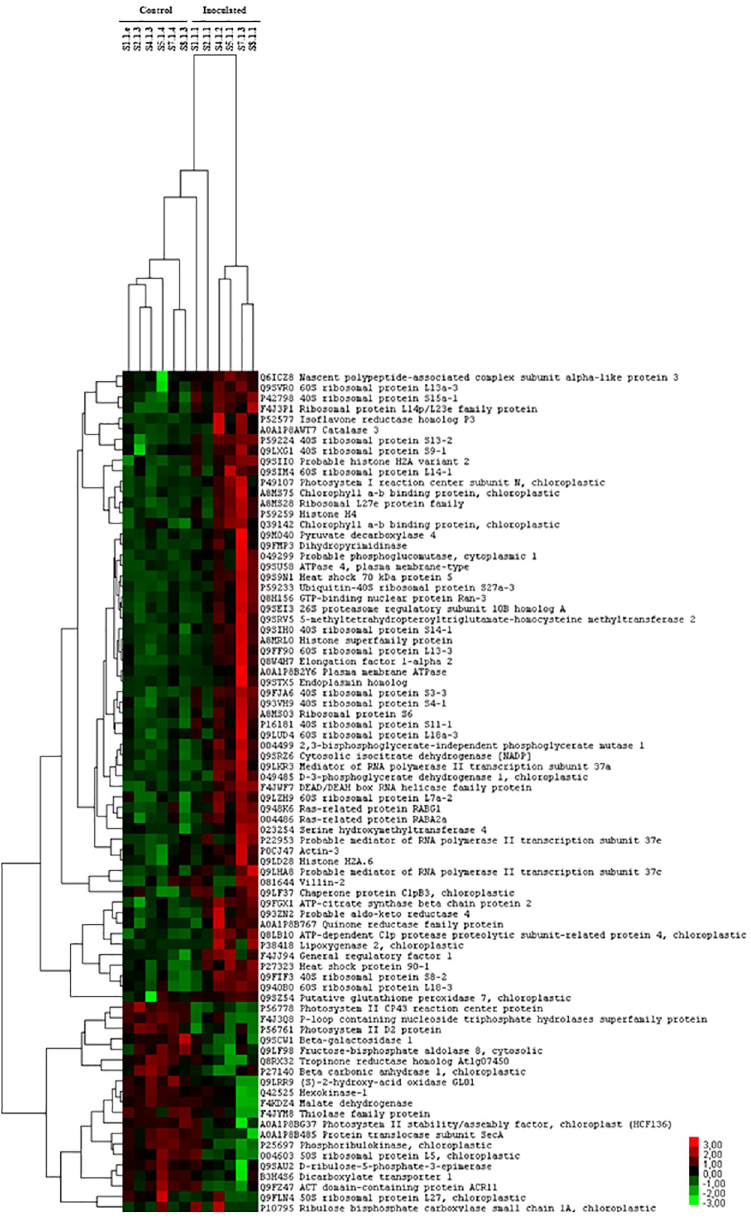
Fig 2. Hierarchical clustering of differentially produced cork oak proteins. The heat map clusters the expression patterns of the 80 proteins with altered abundances between inoculated and control plants. Each column represents one cork oak plant; the control (C) plants are the first 6 columns on the left, and the 6 columns on the right are the inoculated (I) plants. The first 60 lines starting from the top of the heat map are proteins with an increased level in the inoculated samples (red color code) and the 20 lines towards the bottom, are proteins with a decreased level in the inoculated samples (green color code). The color scale of the heat map ranges from -3 to 3 (from light green to red).